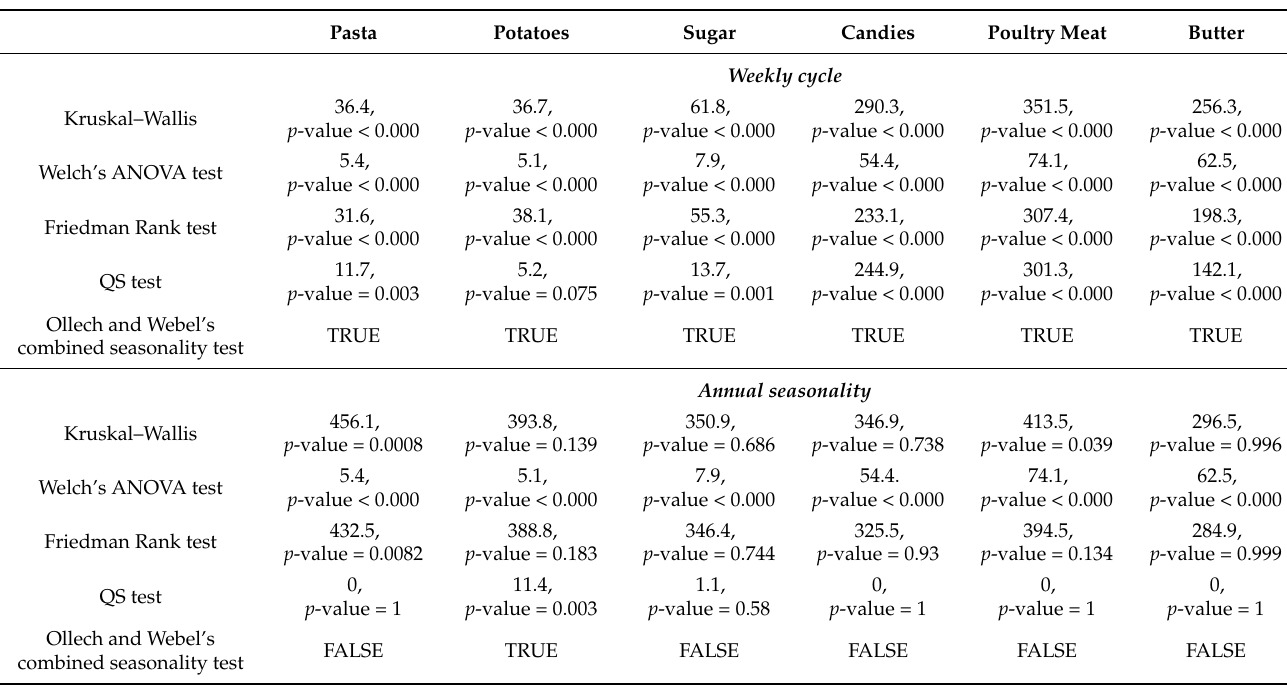
Table A1. Tests results for seasonality in spatial autocorrelation (invers distance matrices).